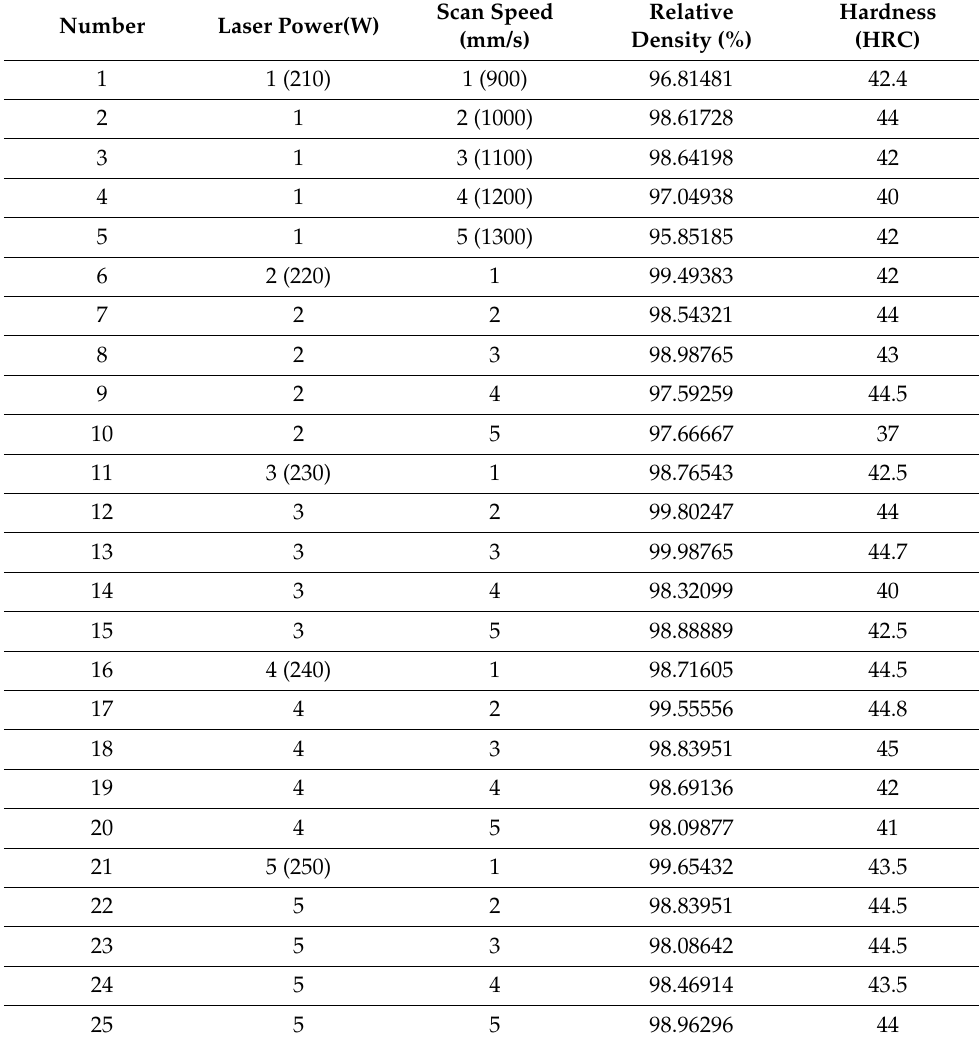
Table 2. Design and results of the orthogonal